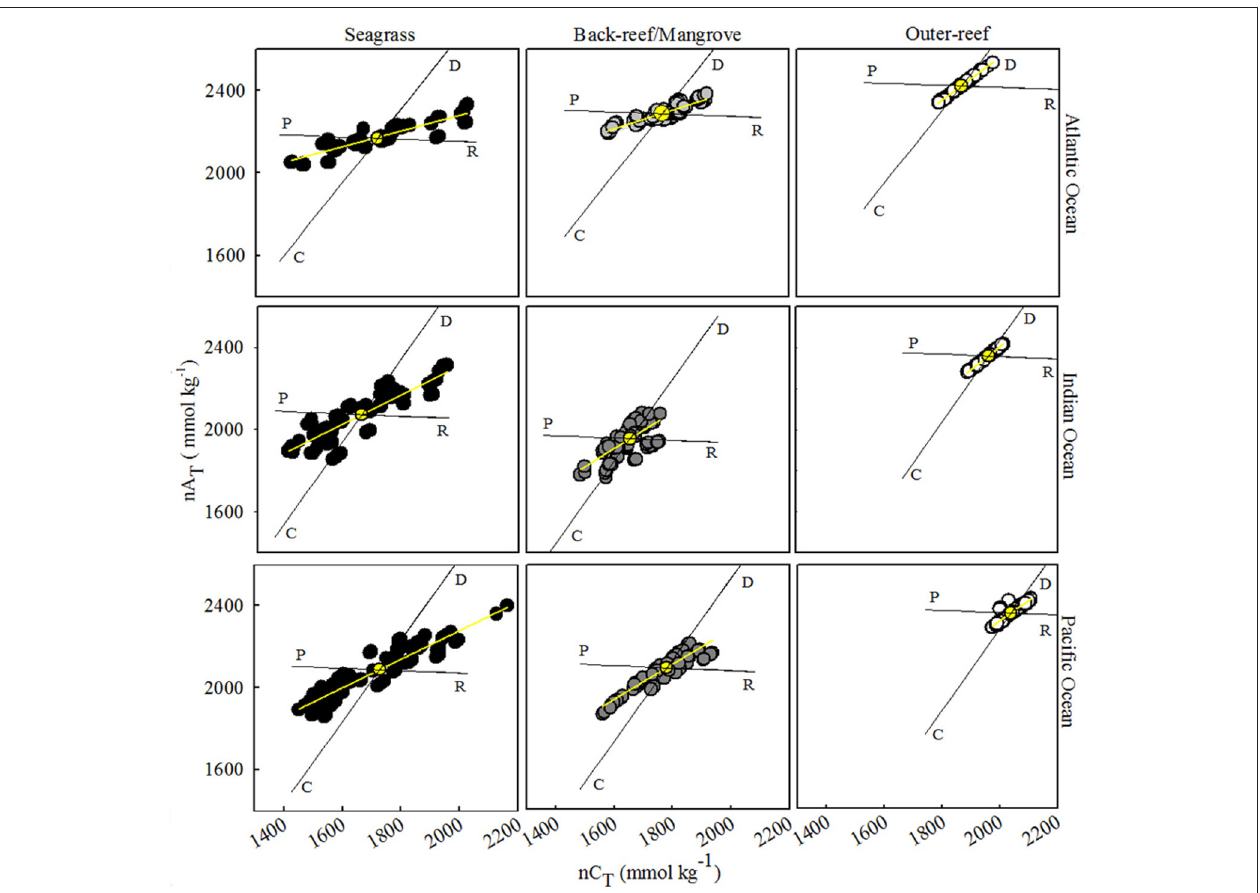
FIGURE 1 | Salinity-normalized total alkalinity (nA T ) and total carbon (nC T ) plots with best-fit linear regression for three sites and habitats in the Atlantic (AO), Indian (IO), and Pacific Oceans (PO). Data is from 5 days over a 2 week period during the dry seasons for each region between 2013 and 2014. The AO site consisted of a seagrass, back-reef and outer-reef control, whilst the IO and PO sites had a seagrass, mangrove and outer-reef habitat. Black lines represent the theoretical impact of calcification (C), carbonate sediment dissolution (D), photosynthesis (P), and respiration (R) on nA T and nC T . Average nA T and nC T is indicated by a yellow dot. C and D are dominant processes when a linear regression slope approaches 2.